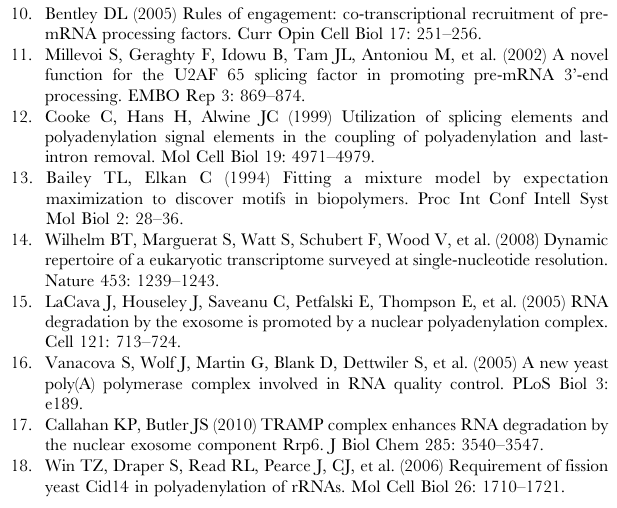
Figure S5 Stability of transcripts with a normal 3’ OH end or with a ribozyme-generated 2’–3’ cyclic phosphate end. The rec8 D